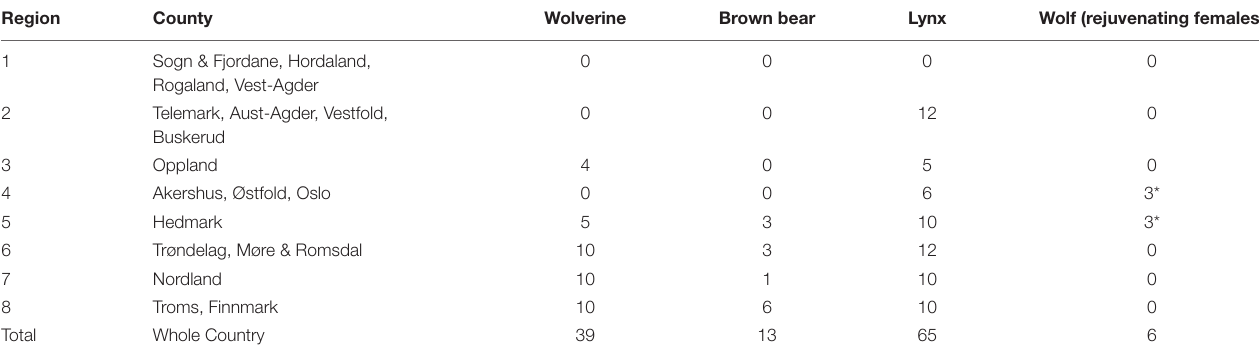
TABLE 2 | Population goals for large carnivores in the eight Norwegian regions 1 . Region County Wolverine